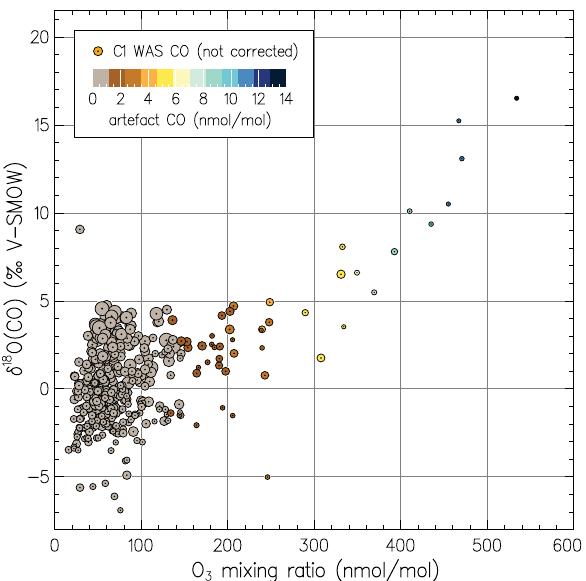
Figure 3. 18 O/ 16 O isotope composition of CO as a function of its reciprocal mixing ratio. Triangles present the data from the re- mote SH UT/LMS obtained by Brenninkmeijer et al. (1996) (B96). Colour refers to the concomitantly observed O 3 abundances; note the extremely low [O 3 ] encountered by B96 in the Antarctic “ozone hole” conditions. Filled and hollow circles denote the original and corrected (as exemplified by the dashed arrow) C1 WAS data, re- spectively, with the symbol size scaling proportional to the esti- mated contamination magnitude (see text).